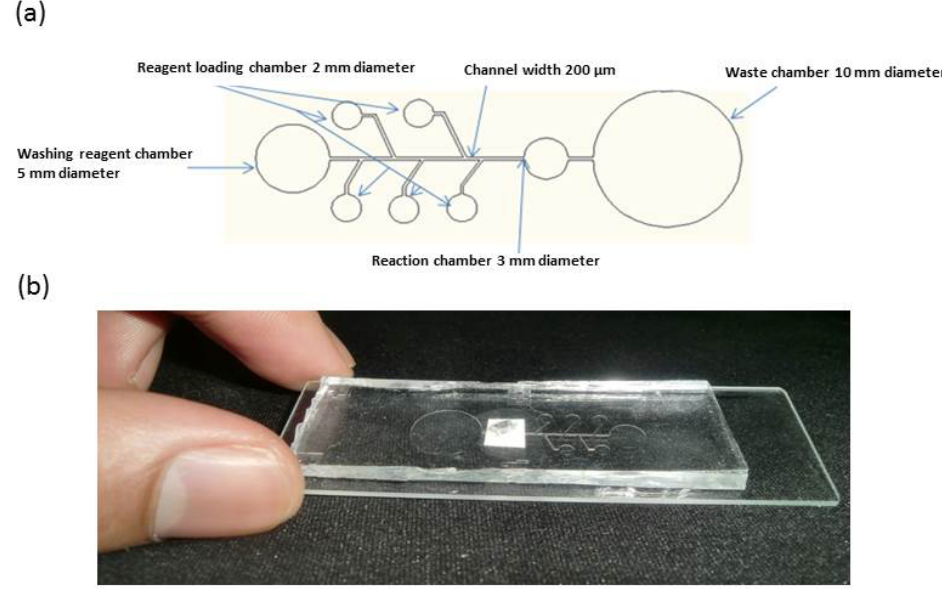
Figure 2. ( a ) scheme for microfluidic platform design ( b ) fabricated microfluidic platform (white color depicts the nitrocellulose coating at the reaction chamber).